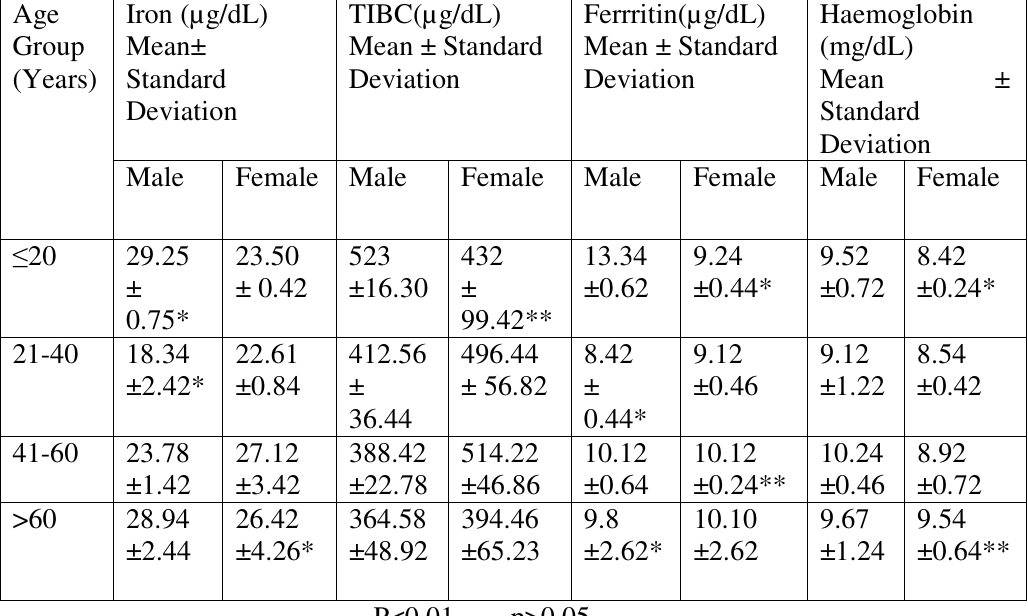
Table-5: Prevalence of Iron Deficiency Anaemia with Iron, TIBC, Ferritin and Haemoglobin according to age and